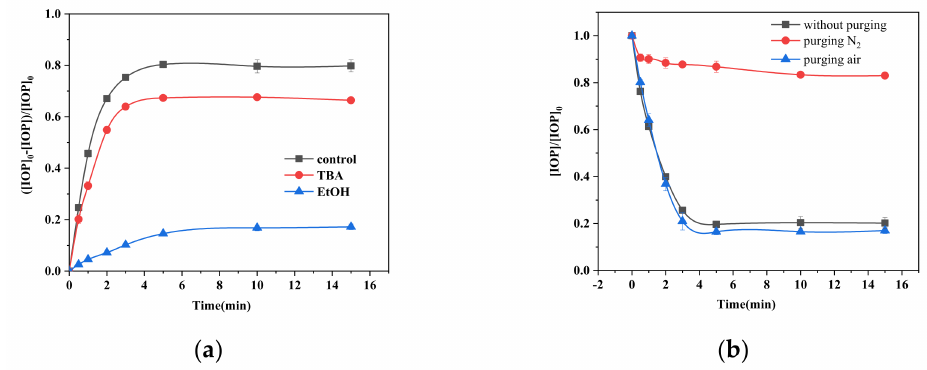
Figure 5. ( a ) Effects of TBA and EtOH on the degradation of IOP by the FeS/sulfite system. ( b ) Effects of purging the FeS/sulfite system with N 2 or air on IOP degradation. Conditions: [IOP] 0 = 1.5 mg L − 1 , [Na 2 SO 3 ] 0 = 400 µ mol L − 1 , [TBA] 0 = [EtOH] 0 = 1 mmol L − 1 , pH init =